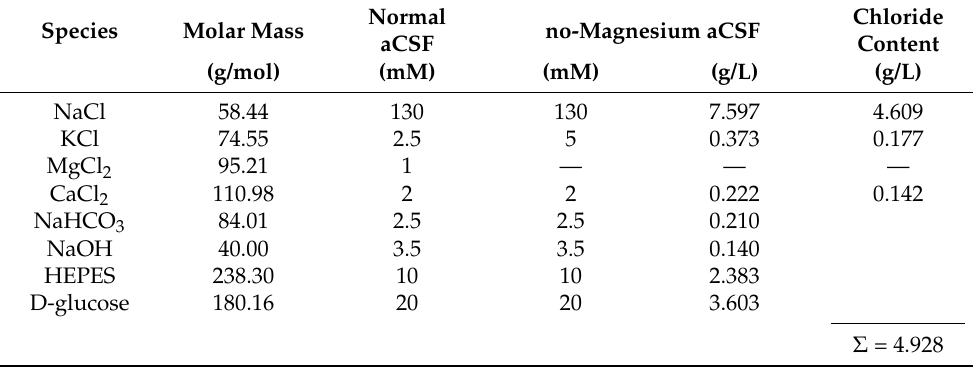
Table 3. Chemical composition of Normal and no-Magnesium (no-Mg) artificial cerebrospinal fluids (aCSF) used in mouse cortical thin-slice experiments. Last column lists chloride concentrations for the no-Mg fluid. Total chloride concentration Σ = 4.928 g/L corresponds to chlorinity [ m Cl ] = 4.904